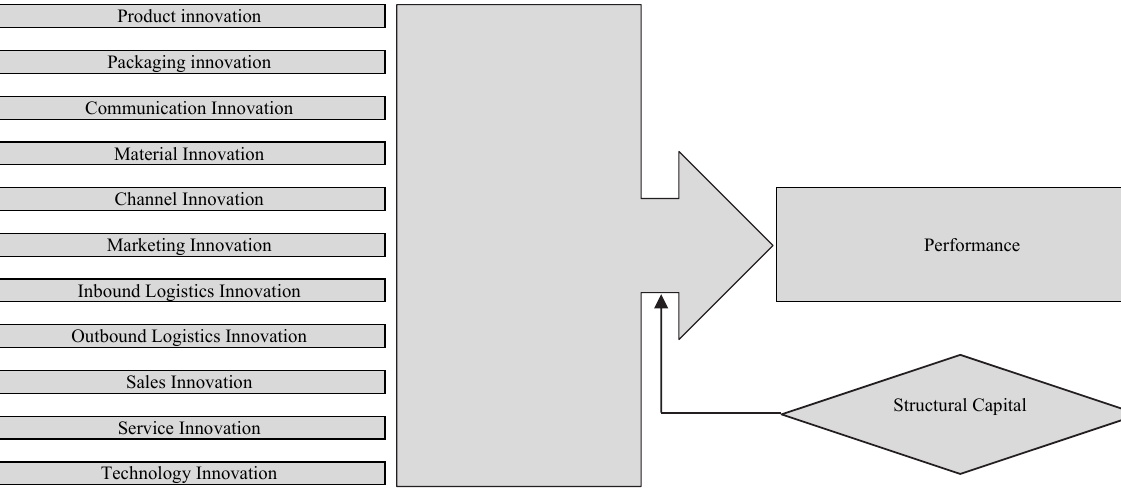
Fig. 1. The framework of the proposed study